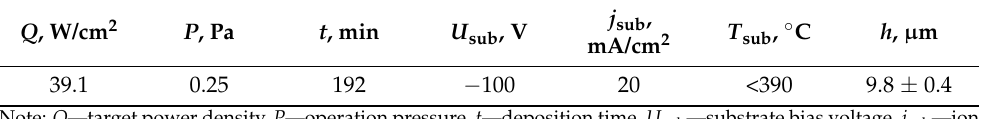
Figure 1. The photographs of the samples ( a ) before and ( b ) after oxidation at 1100 ◦ C for 2 min: left sample—partially Cr-coated; central sample—uncoated; right sample—fully Cr-coated. Table 1. Deposition